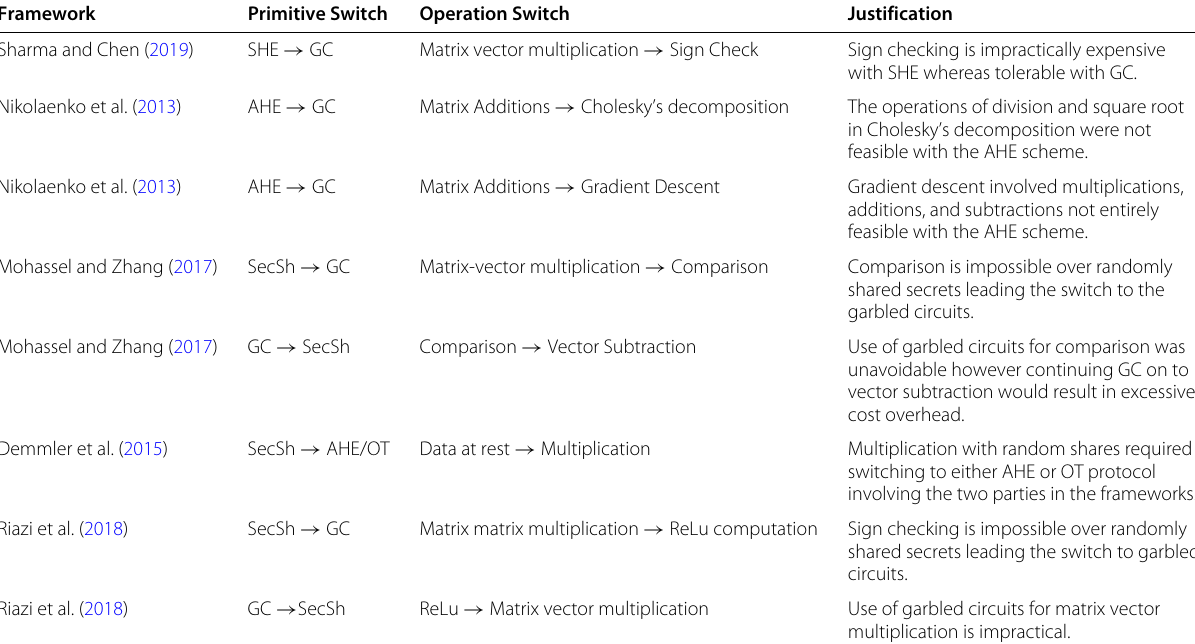
Table 2 Examples for primitive switching strategies in hybrid composition of CML frameworks